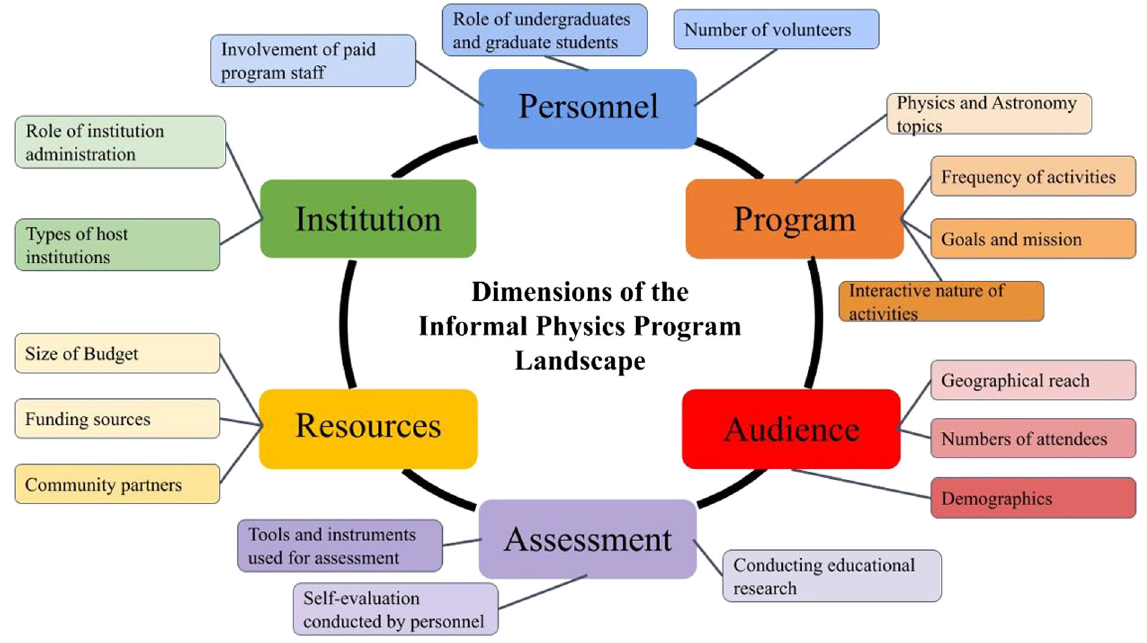
FIG. 13. Landscape dimensions associated with six main components of the organizational framework for the informal physics programs. These dimensions can be useful for practitioners, researchers, and administrators to make connections with other programs and to situate their work in multiple